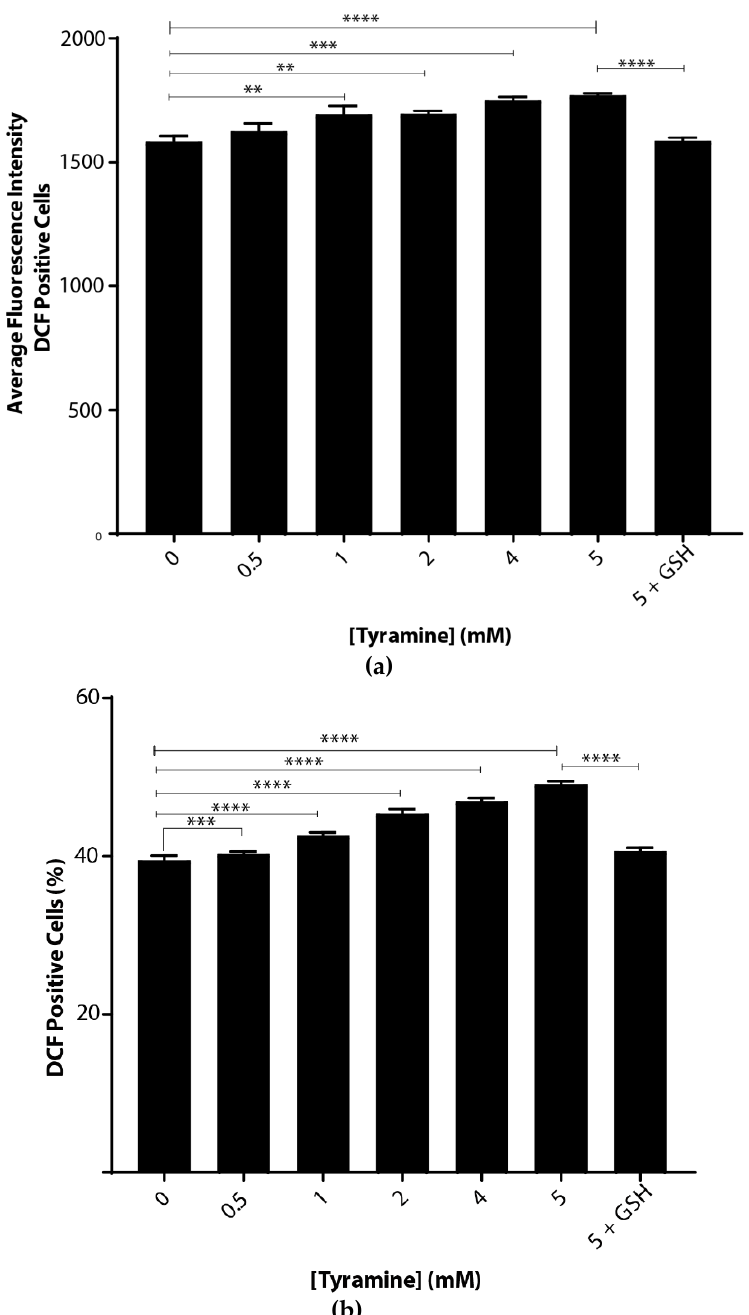
Figure 2. Tyramine dose-dependent ROS determination in Saccharomyces cerevisiae BY4743 using 2′,7′ - dichlorodihydrofluorescein diacetate (H 2 DCFDA) staining. ( a ) Average single-cell fluorescence intensity of the dichlorofluorescein (DCF)-positive yeast cells at different concentrations of tyramine and ( b ) dichlorofluorescein (DCF)-positive cell counts after tyramine treatment. The concentration of 5 mM glutathione was used for rescue of the cells from oxidative stress. Values are from triplicates; values significantly different from 0 mM tyramine in one-way ANOVA, and values significantly different from 5 mM tyramine are indicated (** p < 0.01, *** p < 0.001 and **** p < 0.0001). 3.2. Tyramine Exacerbates Oxidative Stress in Yeast Producing N ative Aβ42 Tyramine induced ROS formation to a greater extent in yeast strain BY4743 (pYEX.A β ) as compared to that of empty vector control BY4743 (pYEX.BX) demonstrated by H 2 DCFDA staining.